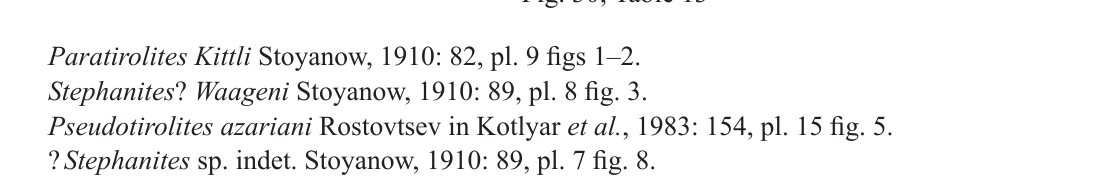
fig. 67. — Kummel 1957: 179, text-fig. 1a–b. — Shevyrev 1965: 174, pl. 22 fig. 4; 1968: 90, pl. 3 fig. 1. — Korn & Ghaderi in Korn et al. 2016: 862, text-figs